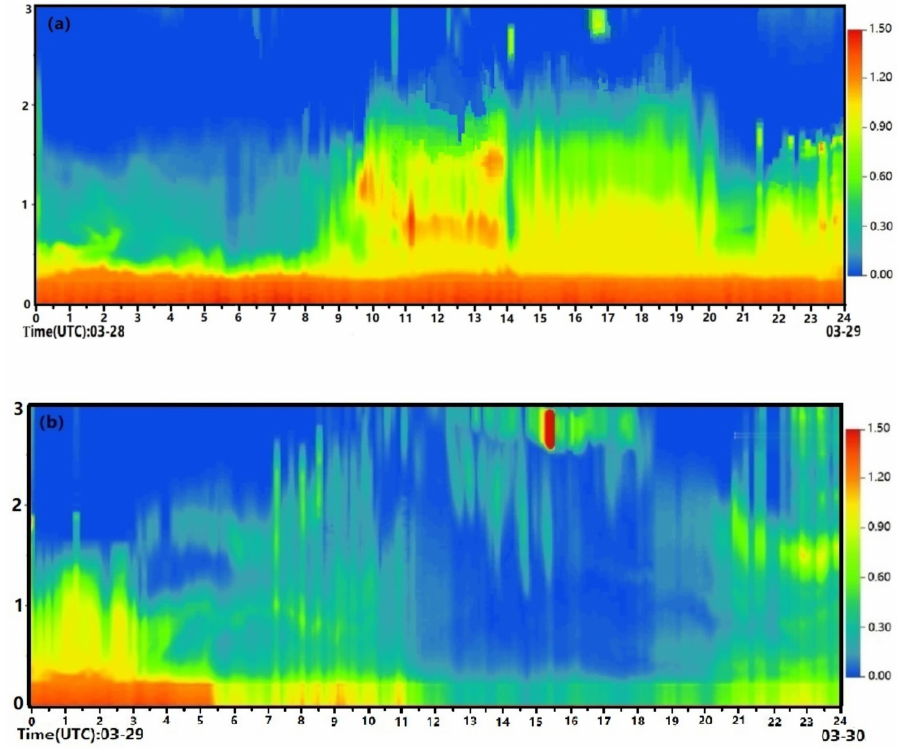
Figure 4. Vertical profile of the extinction coefficient of the aerosols within 3 km above the ground observed via LiDAR in Jinan: ( a ) 28 March 2021; ( b ) 29 March